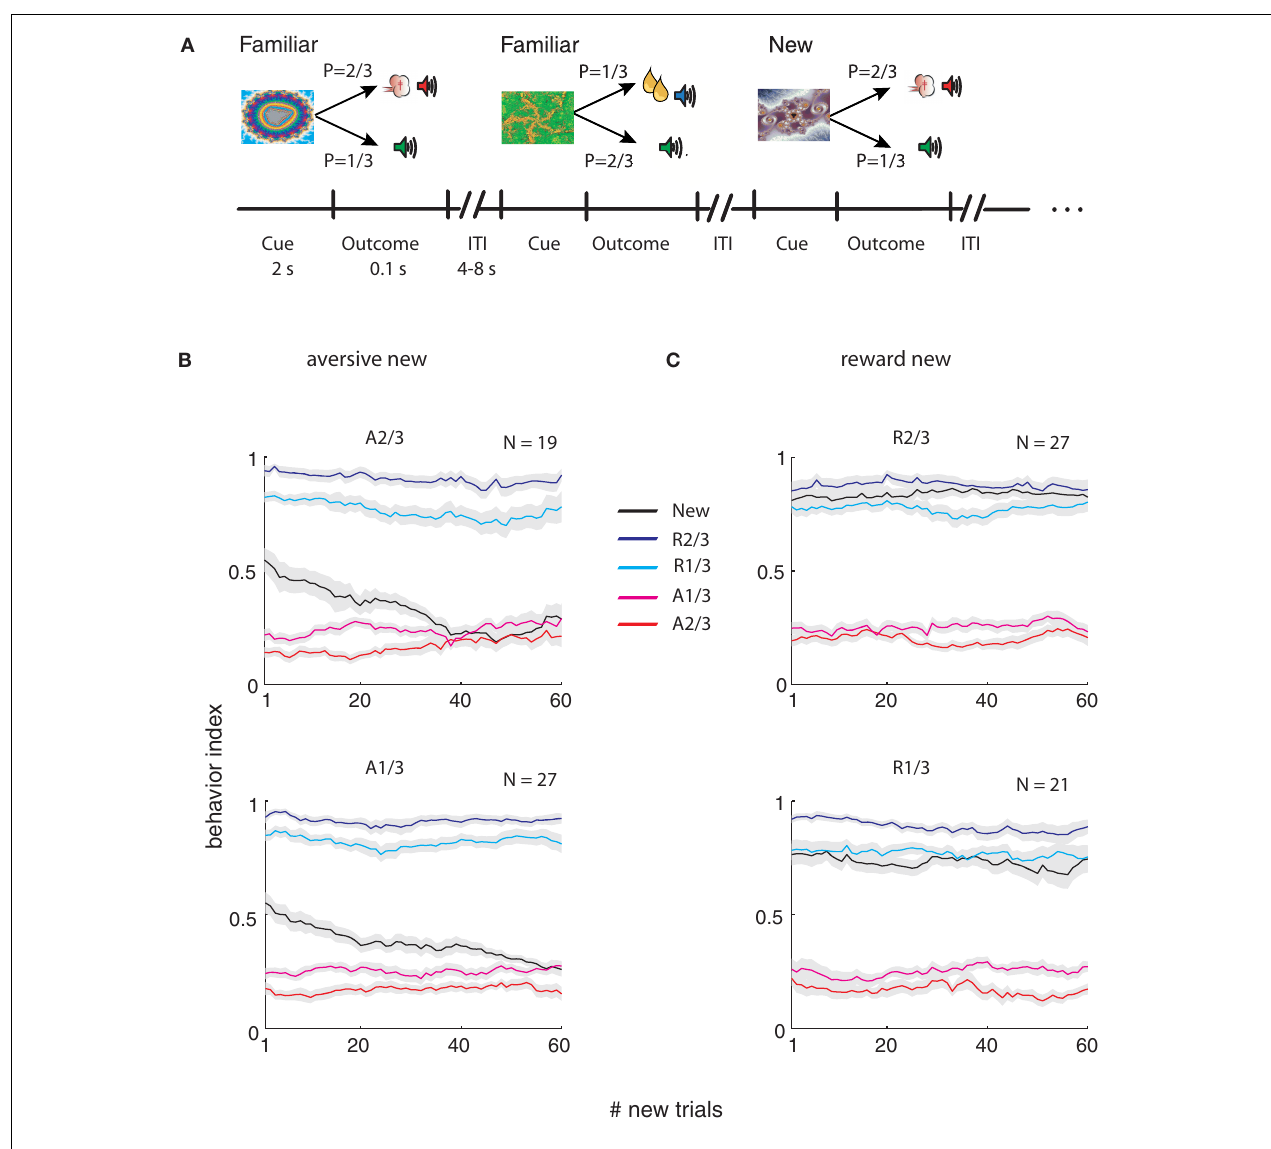
average of 20 new trials (and corresponding familiar events). Bin 1 is therefore the average of the fi rst 20 trials, and so on. The responses were normalized between 0 and 1 for each session and then averaged across sessions. Top – new cue is p = 2/3 aversive cue. Bottom- new cue is the p = 1/3 aversive cue, The N in the top-right corner of each plot is the number of recording sessions. (C) Same as (B) for the sessions with new reward cues (Top, p = 2/3; bottom, p = 1/3 new reward